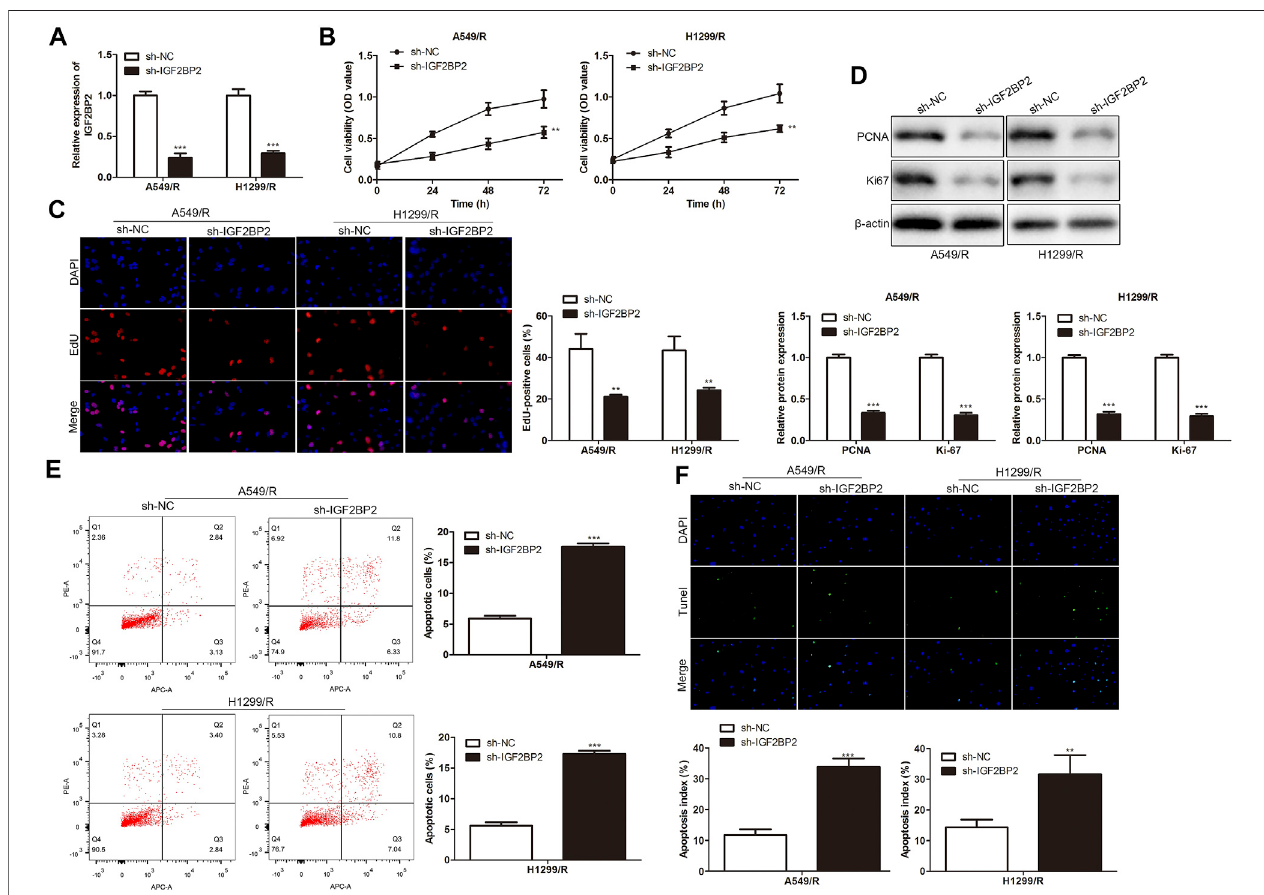
FIGURE 5 | Inhibition of IGF2BP2 depresses crizotinib-resistance of NSCLC cells. (A) RT-qPCR detected the level of IGF2BP2. (B) CCK-8 assay assessed the viability of crizotinib-resistant NSCLC cells. (C) EdU assay evaluated the proliferation of crizotinib-resistant NSCLC cells. (D) Western blot measured the level of proliferation-related proteins, including PCNA and Ki-67. (E) FACs detected apoptosis of crizotinib-resistant NSCLC cells. (F) TUNEL staining assessed apoptosis of crizotinib-resistant NSCLC cells. ** p < 0.01, *** p < 0.001 vs sh-NC group. Error bars represent SD. Data represent three independent